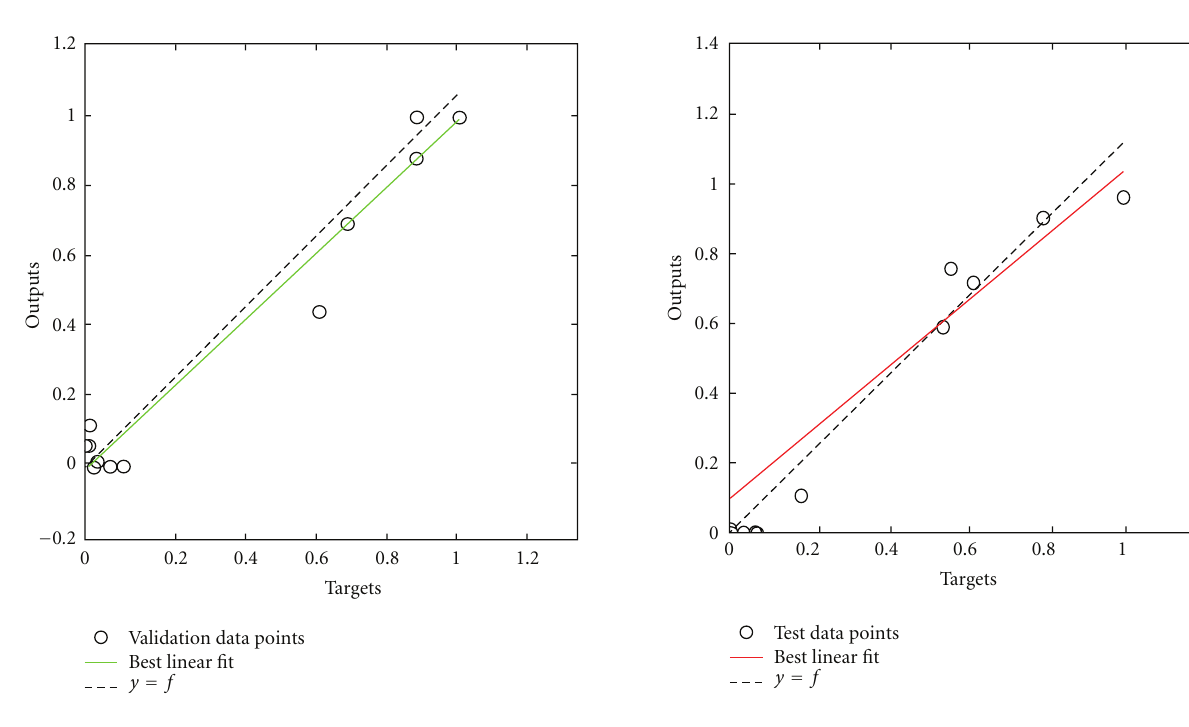
Figure 5: Validation outputs versus targets, with correlation factor R = 0 . 98222.